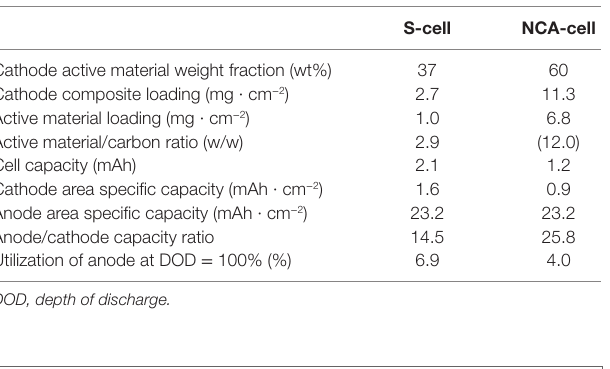
TaBle 1 | specification of the test cells.